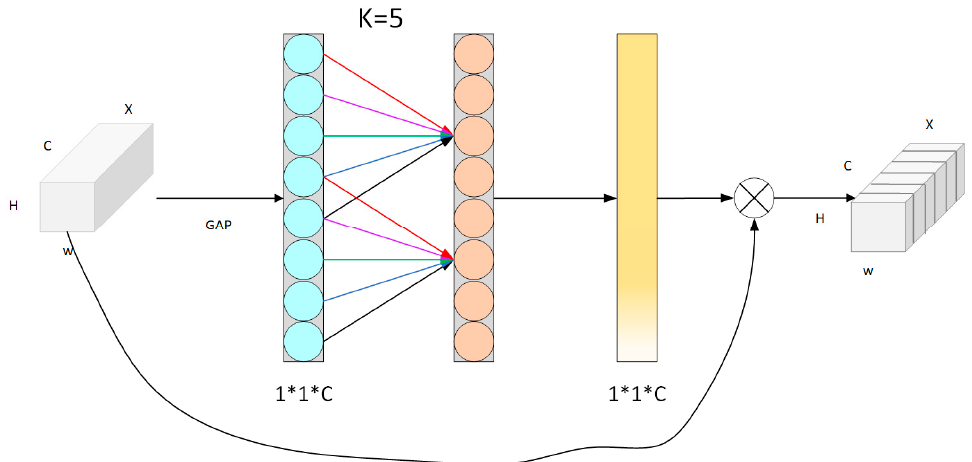
Figure 5. ECA-Net structure. H, W, and C are the length, width and channel of the feature map X, respectively.